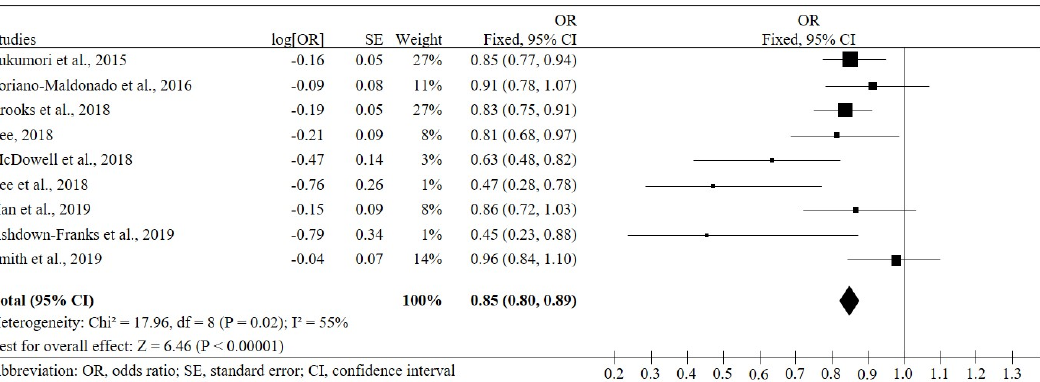
Figure 2. Pooled odds of the association between muscular strength and depression symptoms.